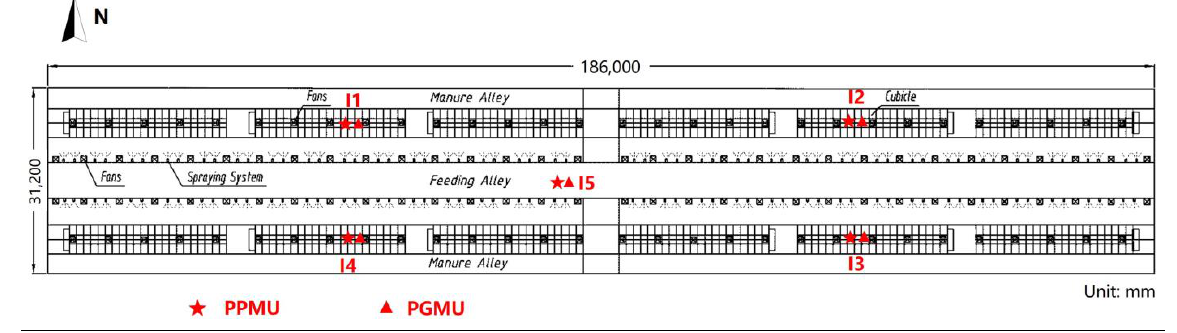
Figure 2. The locations of PM concentration samplers, mixing fans, and spraying systems inside the naturally ventilated dairy barn.